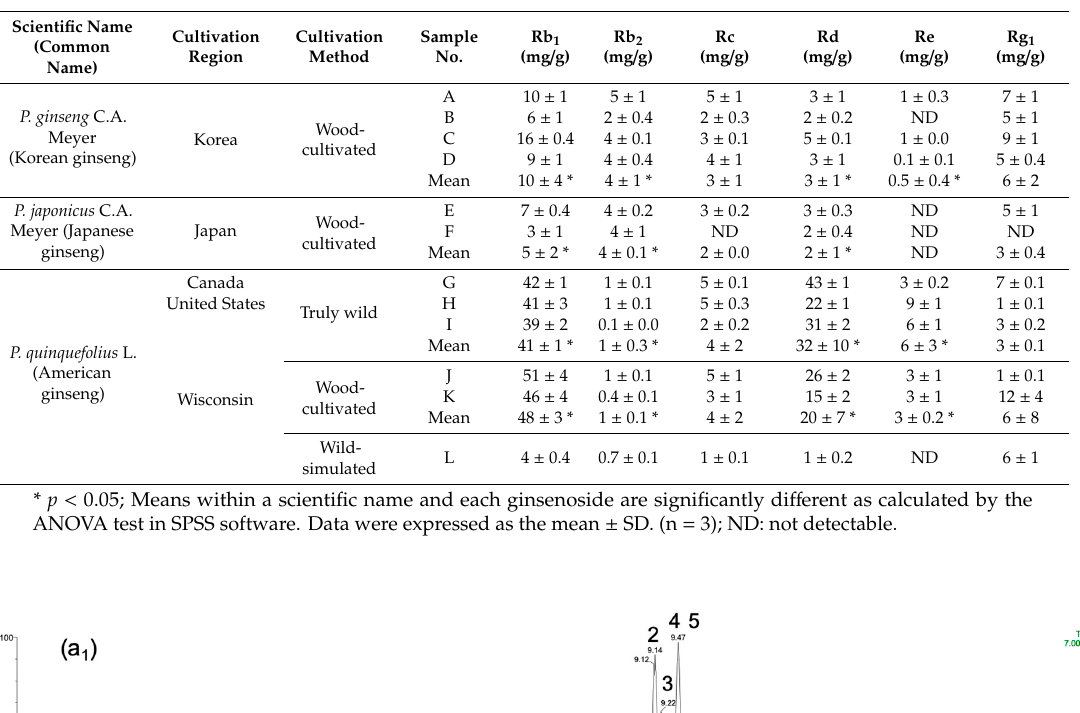
Table 3. Twelve di ff erent sources of ginseng were provided for this study. Contents of ginsenoside Rb 1 , ginsenoside Rb 2 , ginsenoside Rc, ginsenoside Rd, ginsenoside Re, and ginsenoside Rg 1 of the twelve ginseng sources. The average content of ginsenosides is categorized by the scientific name and cultivation method.